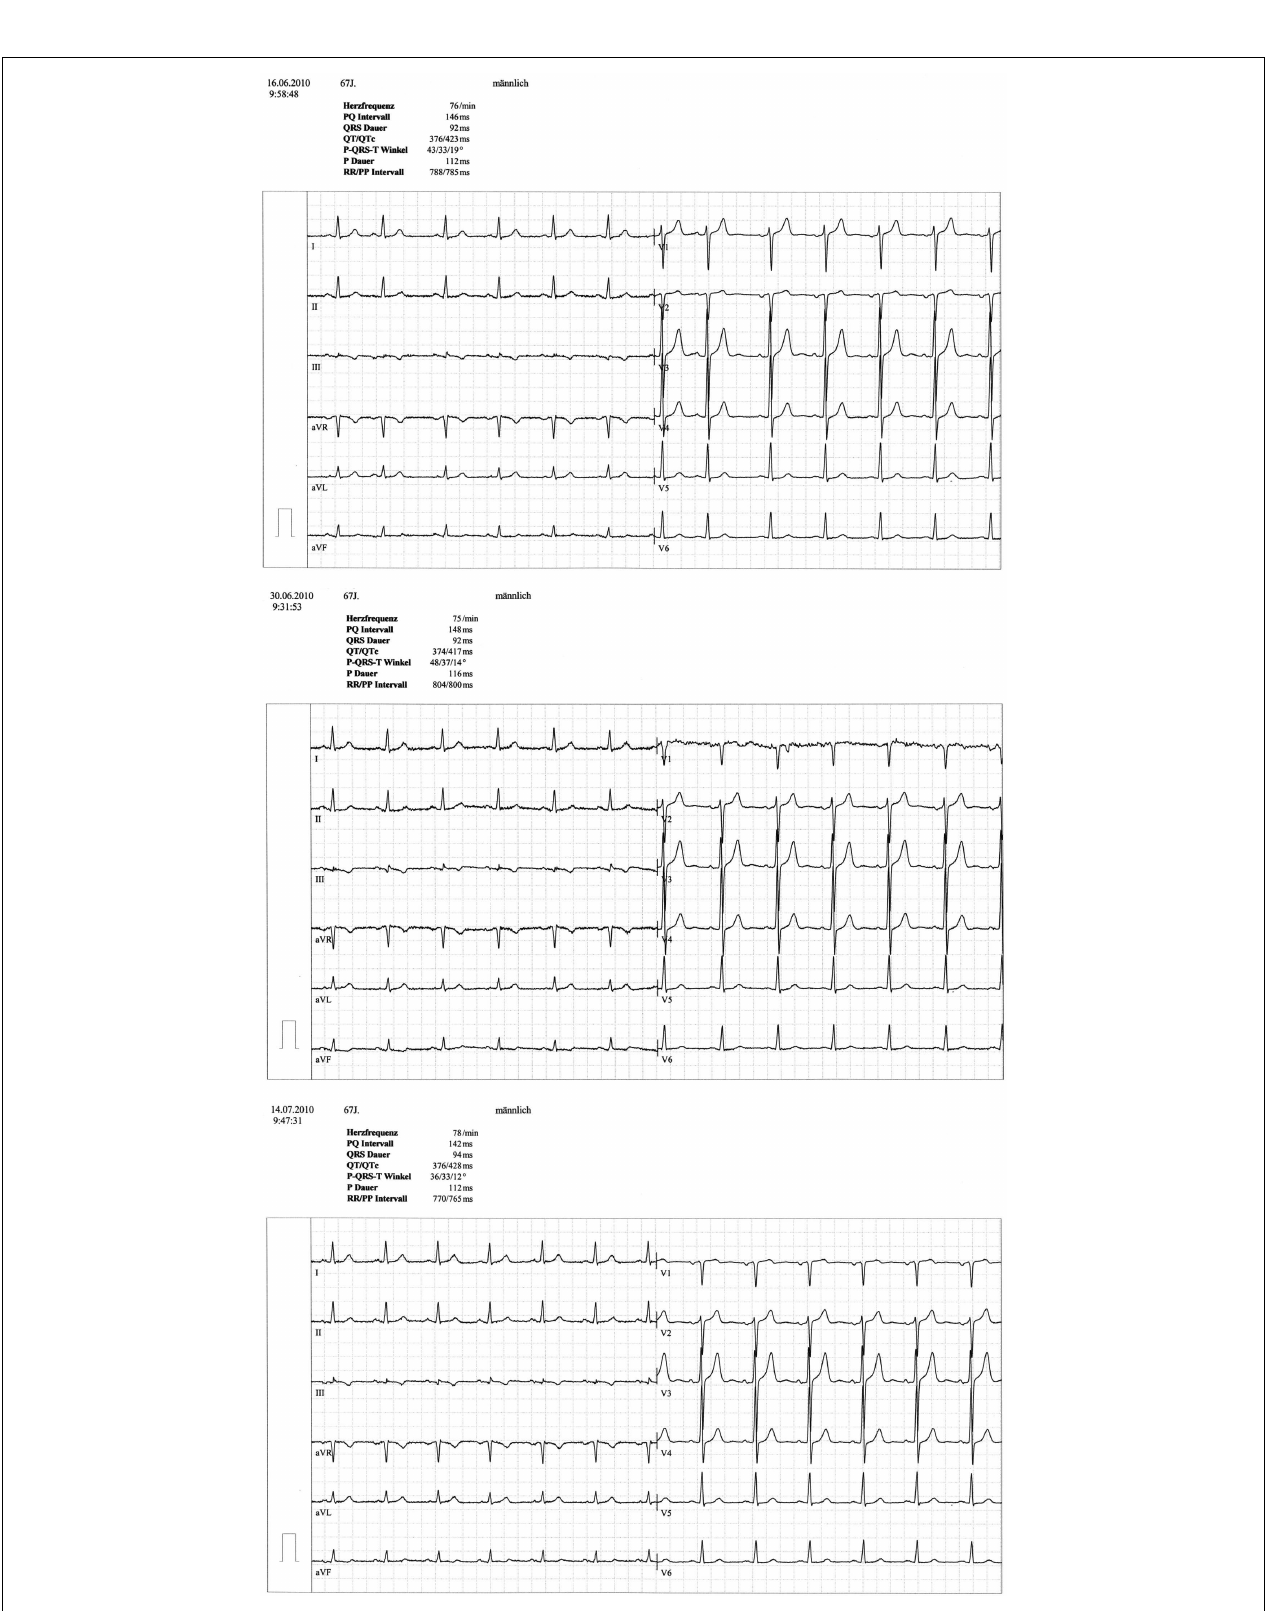
FIGURE 1 | ECG of patient 2 at baseline, week 2 and week 4